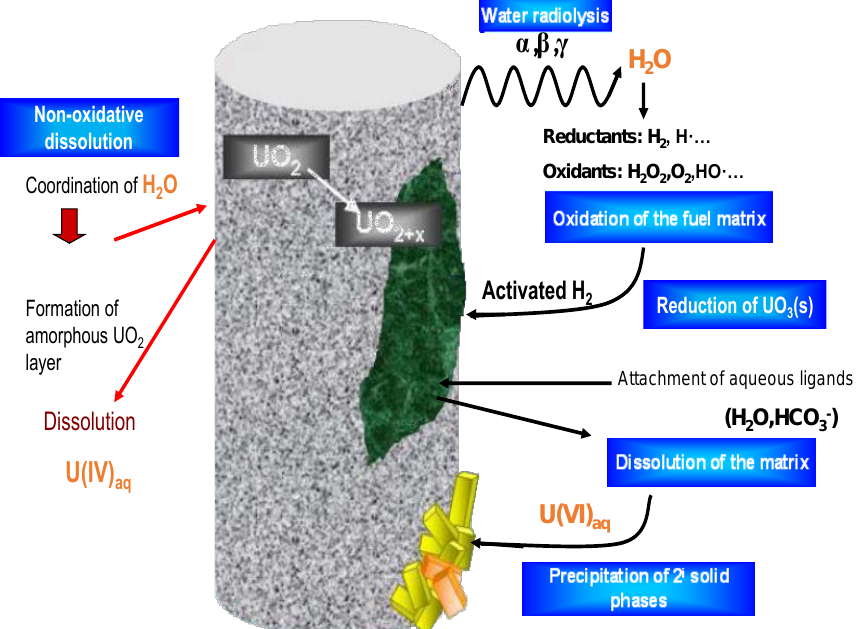
Figure 3. Mechanism for UO 2 dissolution at macroscopic level according to the Matrix Alteration Model, initially formulated in the framework of the EU Spent Fuel Stability project [31] and further developed by Riba et al. [30].